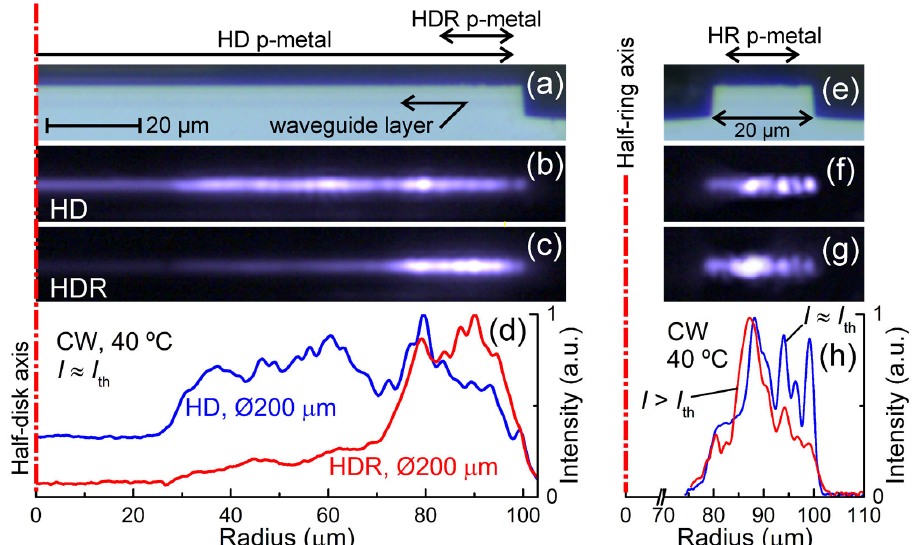
Figure 6. Optical microscope images of a cleaved facet of the right half of a Ø200 µ m half-disk at zero current under external illumination ( a ), and at the threshold pumping of HD ( b ) and HDR ( c ), as well as the corresponding distributions of the radiation intensity along the waveguide layer (the near field profiles) ( d ). Optical microscope images of an edge of the Ø100 μ m HR at zero current under external illumination ( e ), at the threshold pumping ( f ) and above threshold pumping ( g ), as well as the corresponding distributions of the radiation intensity along the waveguide layer ( h ).